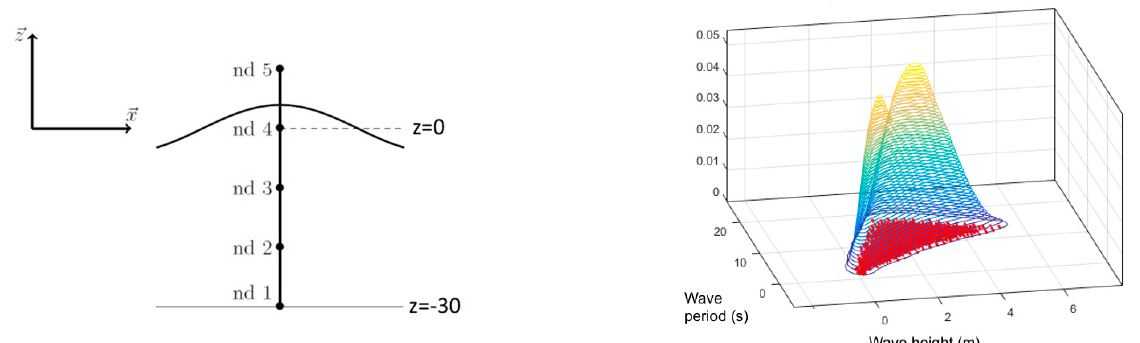
Figure 4. General geometry and finite element model ( left ) and joint PDF of H and T ( right ).